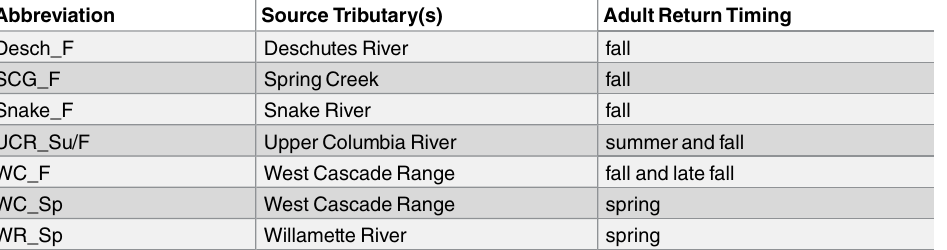
Table 2. A list of the stock of originabbreviations, theirsource tributarieswithinthe Columbia River basin,and returntimingof theirstock of